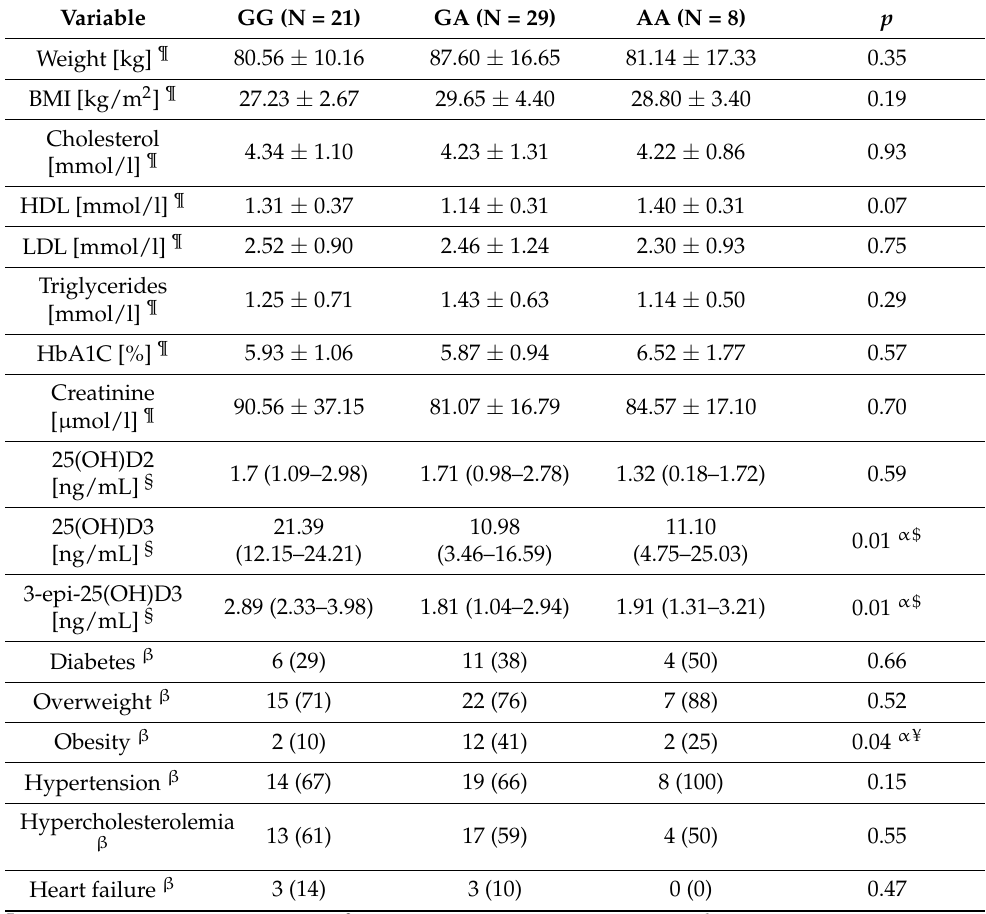
Table 5. Patient characteristics according to the BsmI